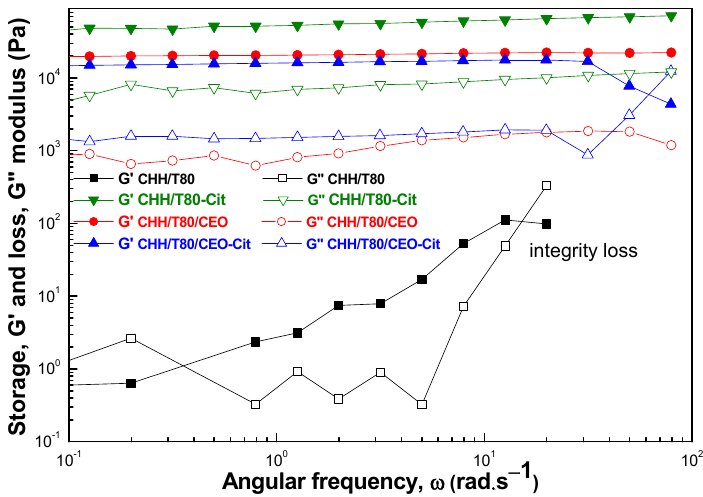
Figure 9. Angular frequency dependence of storage (G ′ , filled symbols) and loss (G ″ , open symbols) moduli for the chitosan-based hydrogels (CHH/T80), citrate cross-linked (CHH/T80-Cit) and loaded with clove essential oil (CHH/T80/CEO).